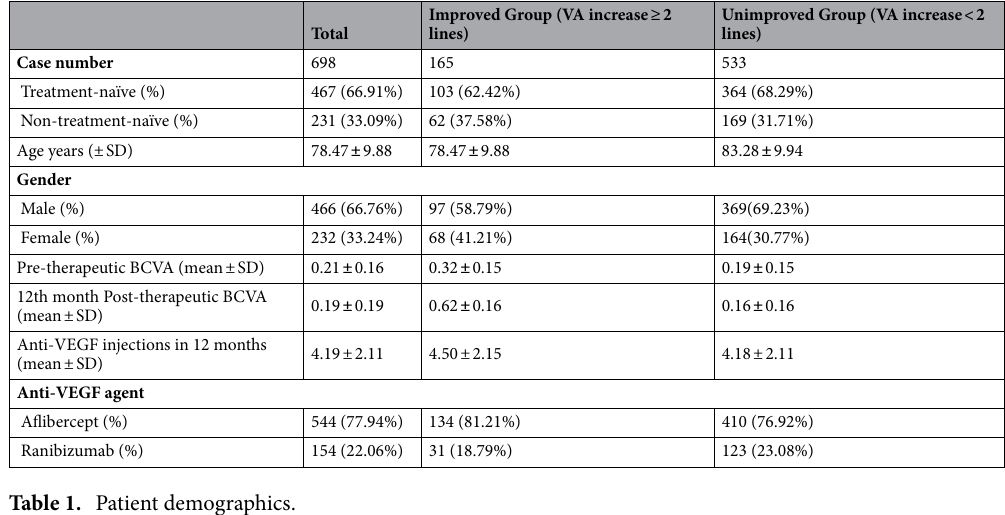
Table 1. Patient